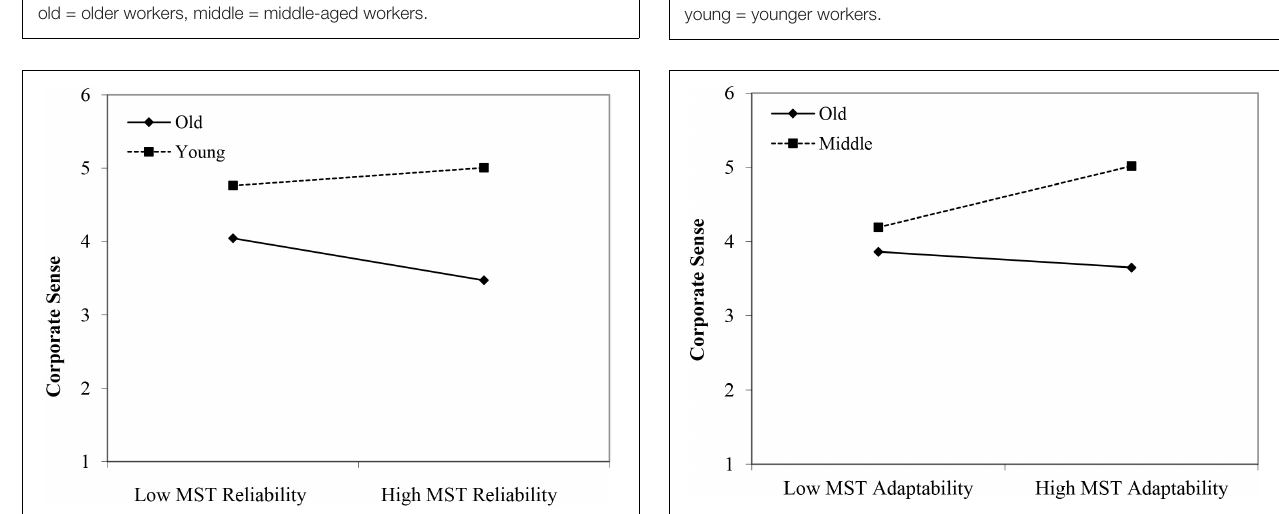
FIGURE 8 | Interaction between perceived age-based (meta-)stereotyping reliability and age groups: Predicting corporate sense. Low = − 1 SD , High = + 1 SD , MST = age-based (meta-)stereotyping reliability, old = older workers, young = younger workers.